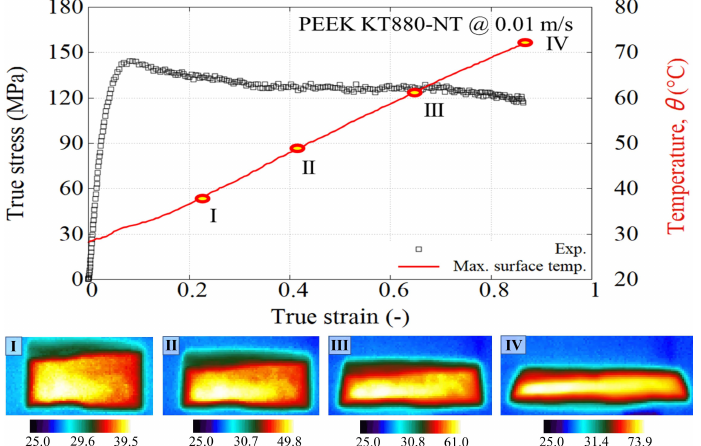
Figure 7. Stress-strain response and temperature evolution of PEEK KT880 − NT under compression at 0.01 m/s. Temperature of infrared pictures in